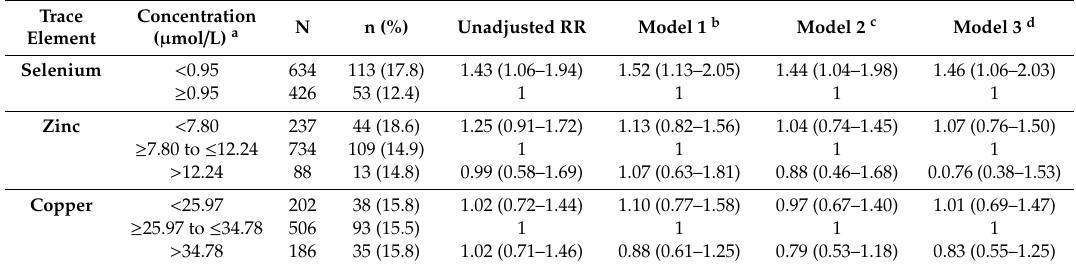
Table 3. Risk for subfertility ( > 12 months to conceive) according to plasma trace element concentration measured at 15 ± 1 weeks’